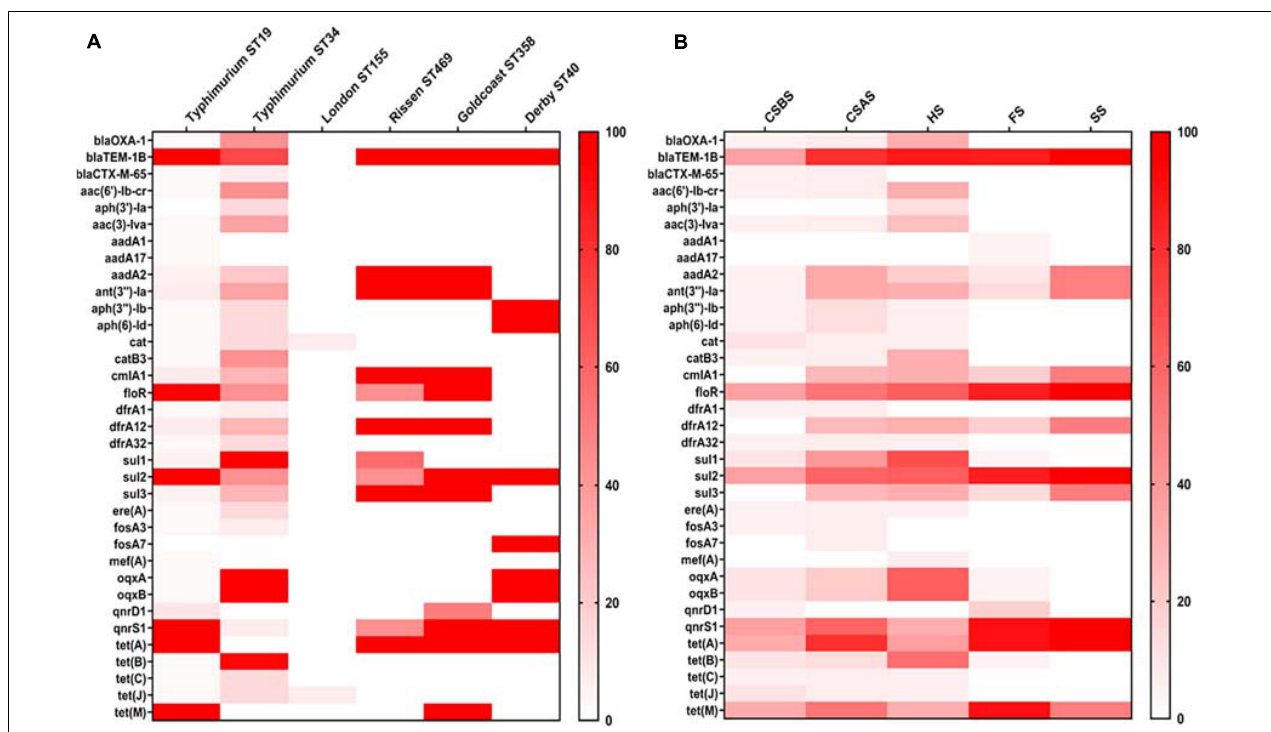
FIGURE 4 | Heatmap of antimicrobial resistance genes according to serovars (A) and sampling sources (B) . The isolates of Salmonella Typhimurium ST34 harbor the most diversified antimicrobial resistance genes. However, Salmonella isolates recovered from HS and CSAS contain more resistance genes compared with those isolated from other sources. CSBS, carcass swabs before splitting; CSAS, carcass swabs after splitting; HS, hepatobiliary samples; FS, fecal samples; SS, sewer samples. TABLE 5 | Phenotypical and genotypical analyses of antimicrobial resistance of Salmonella isolates. Antimicrobial class Antimicrobial agent Coherent results Incoherent results Percentage of incoherence Both